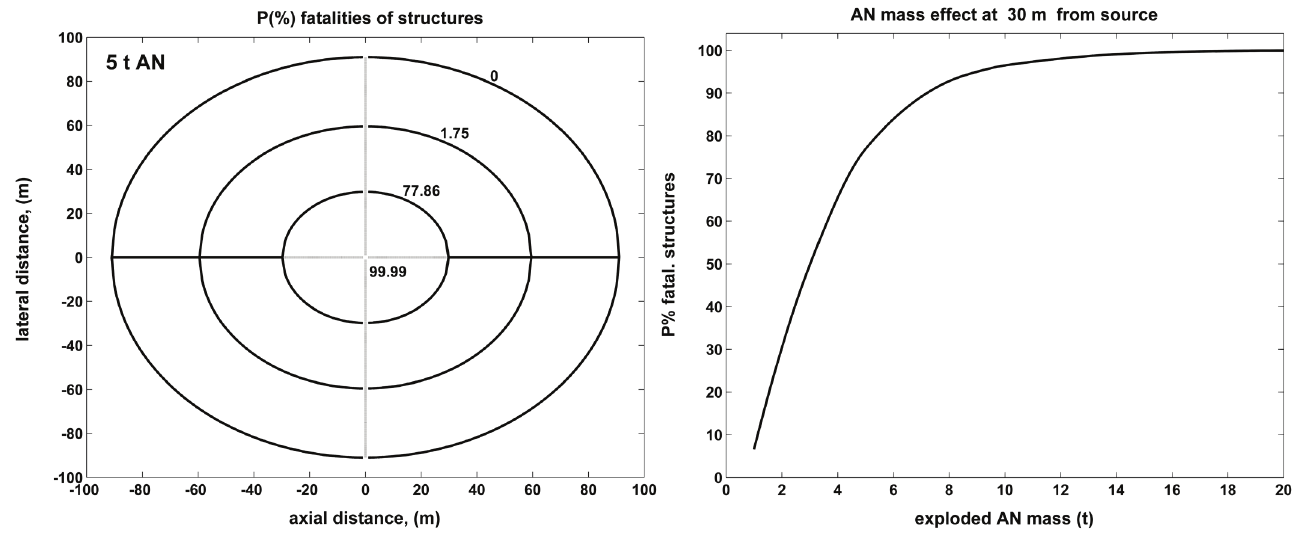
Fig. 6 – P% fatalities of structures (buildings, industrial plants) at various distances from the explosion spot. Note: The circles of iso-parameters present the followings rays: 30 m, 60 m, and 90 m, respectively (case of 5 t AN explosion).